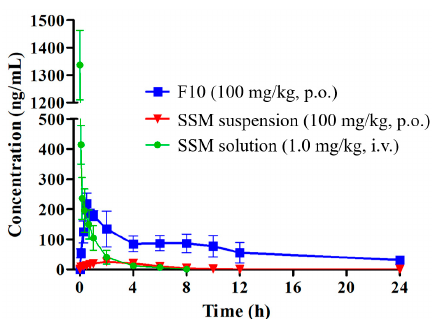
Figure 6. The HPLC-fluorescence chromatograms of ( a ) blank rat plasma; ( b ) blank rat plasma spiked with SSM (20 ng/mL); and ( c ) a rat plasma sample at 5 min after the oral administration of F10 (100 mg/kg). Peak identification: (1) SSM.